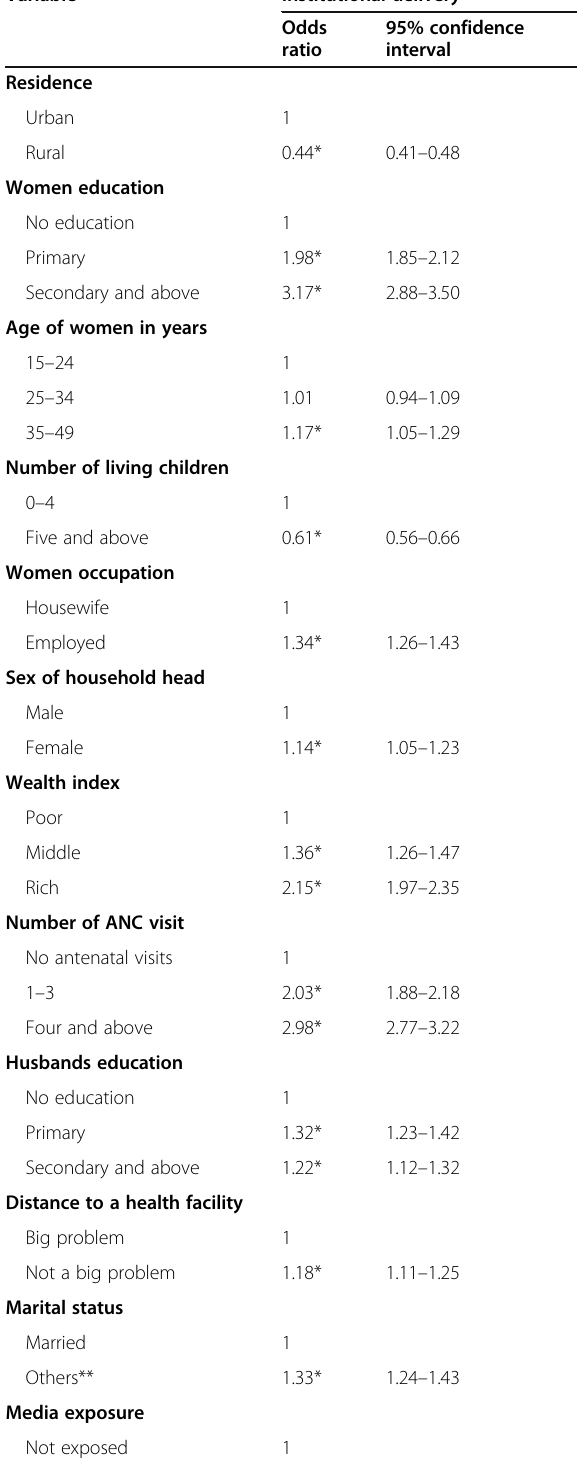
Table 3 Multivariable logistic regression analysis of factors associated with institutional delivery in Sub-Saharan Africa